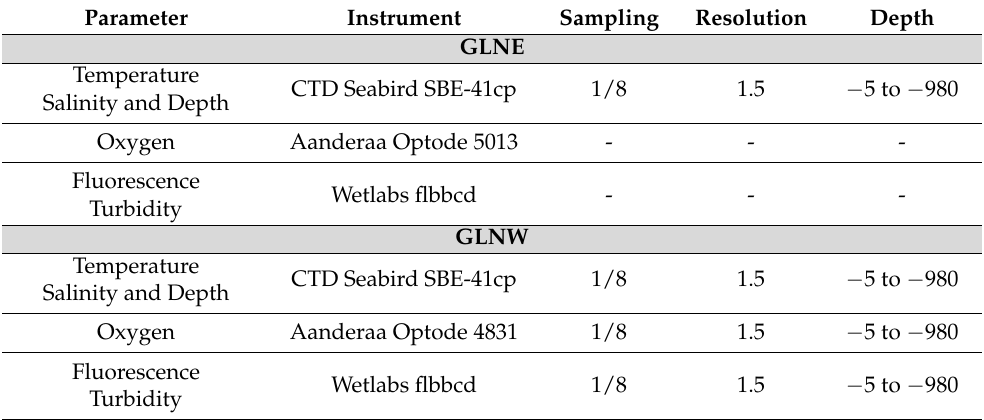
Table 1. Glider instrumentation, sampling rate (Hz), vertical resolution (m) and depth range (m) of collected